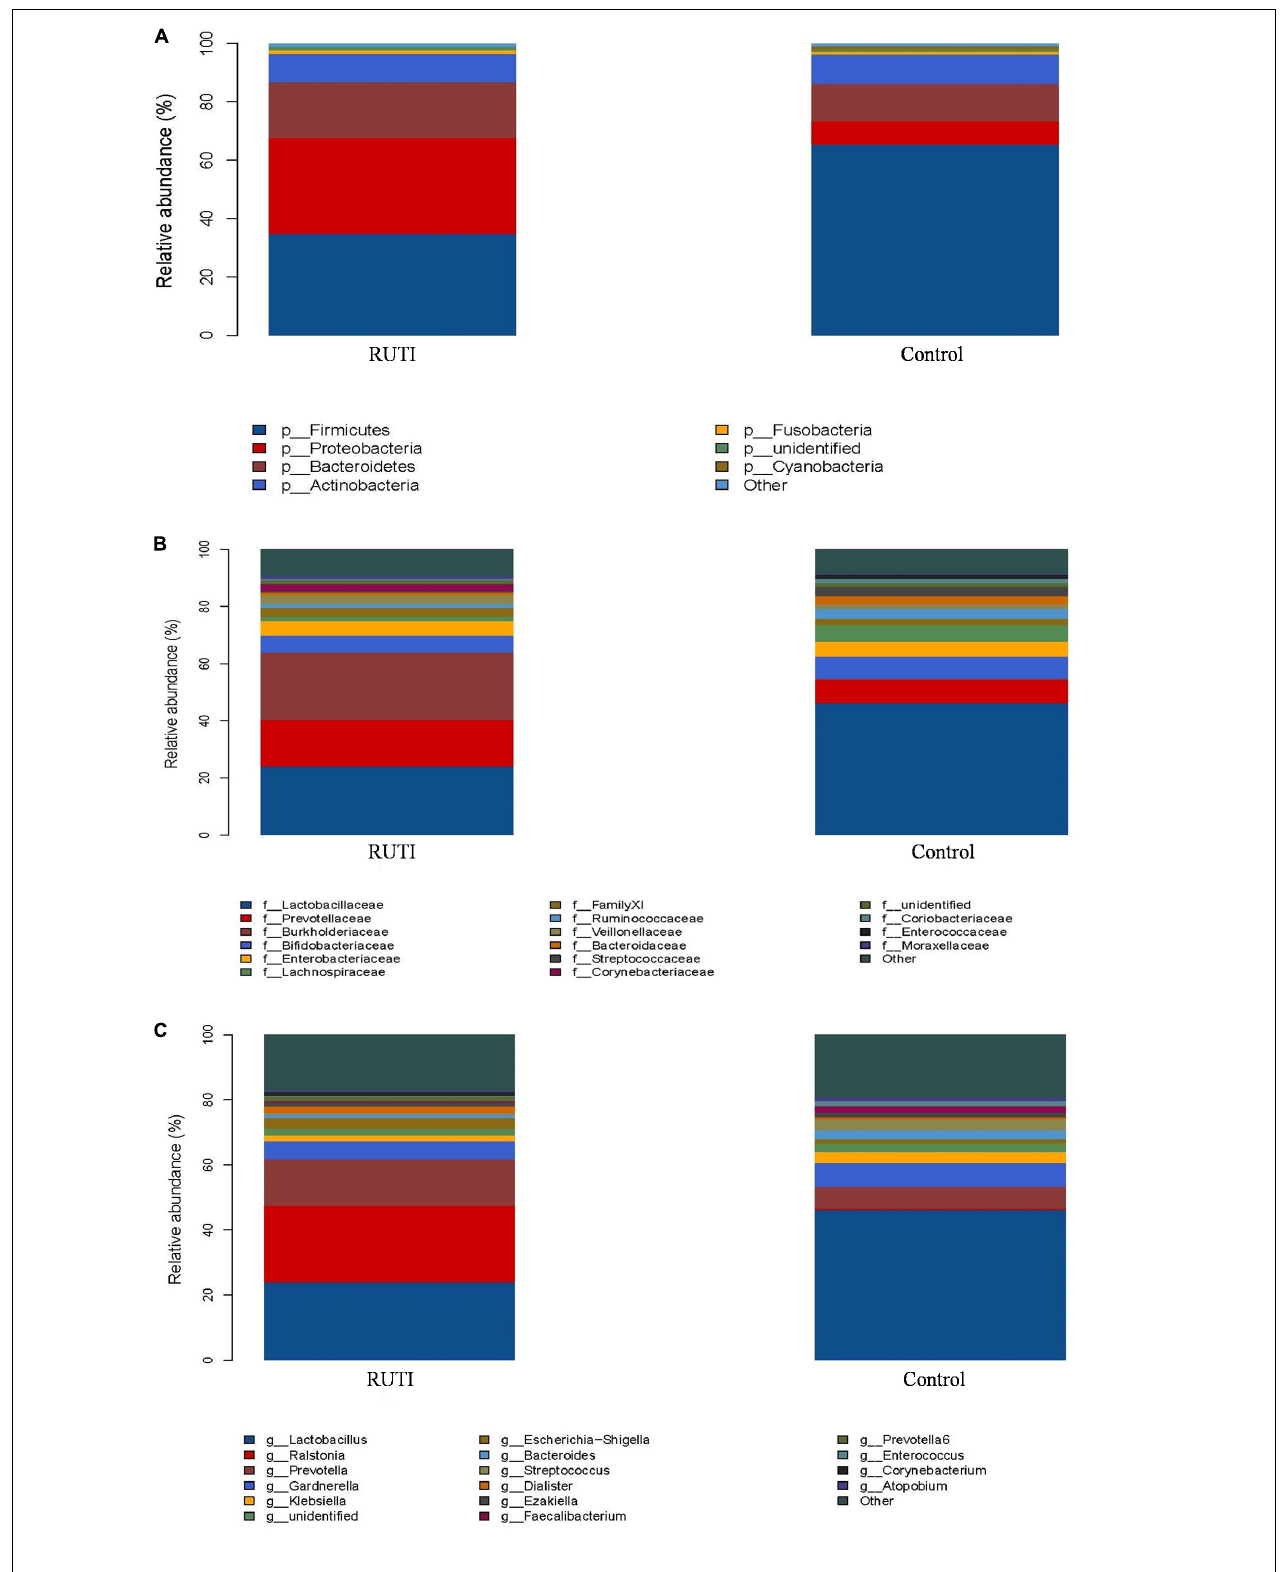
FIGURE 3 | Relative abundance bar plot of phylum (A) , family (B) , and genera (C) in the RUTI and control groups.